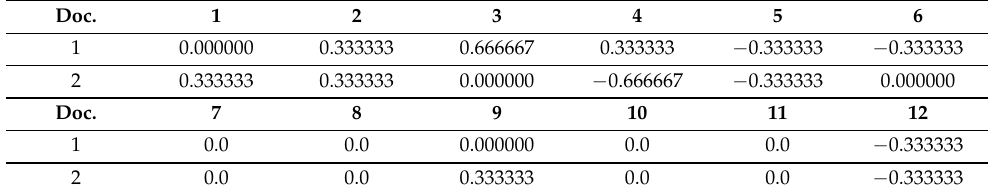
Table 10. The results of hashing on sample